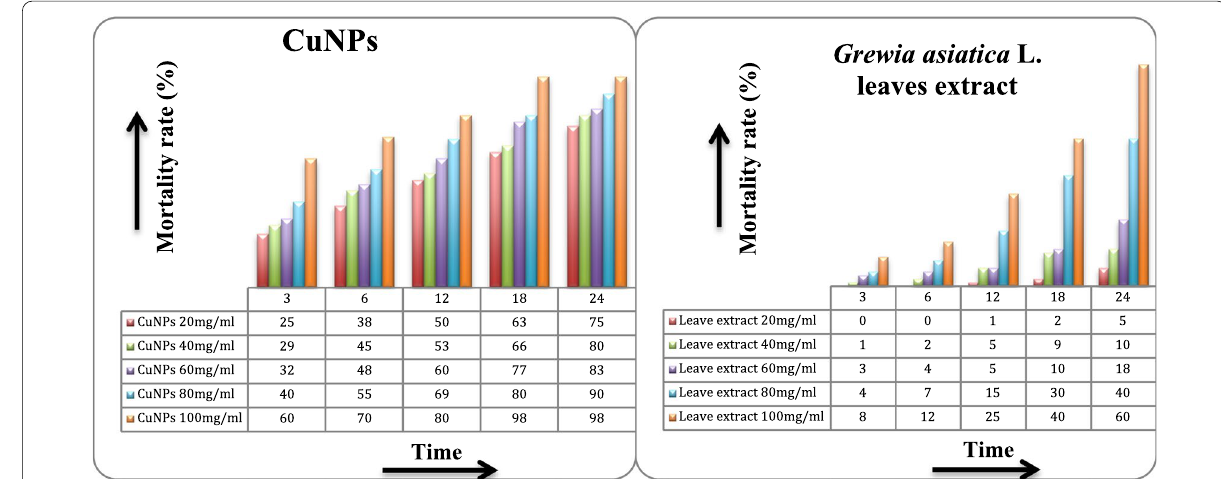
Fig. 7 larvicidal activity of against Aedes aegypti larva